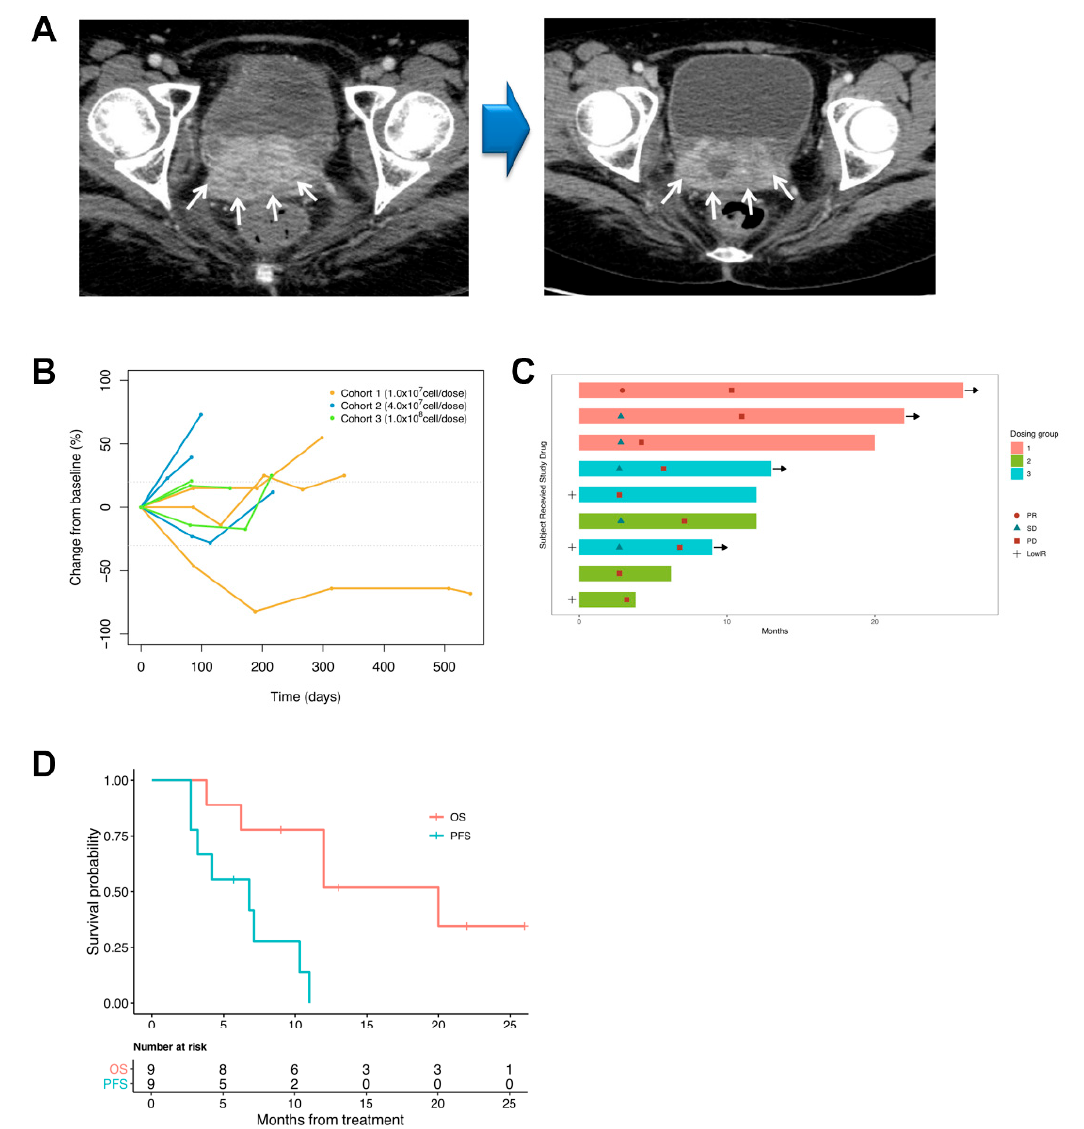
Figure 1. ( A ) Representative CT images during the vaccination protocol. The maximum diameter of the mass was almost stable at follow-up imaging, but it showed central necrosis. White arrows indicate a recurrent tumor. ( B ) Longitudinal change from baseline in tumor size ( n = 9). Dotted lines at 20% and − 30% indicate the percentage change from baseline and represent progressive disease and partial response, respectively, per RECIST v1.1. ( C ) Swimmer plots provide useful information about responses and the potential persistence of these responses even without ongoing treatment. Continuation of response despite immunotherapy discontinuation is an important e ffi cacy metric. Symbols along each bar could be used to represent various relevant clinical events, such as disease progression (PD), stable disease (SD), partial response (PR), or low immune response (LowIR). ( D ) Kaplan-Meier